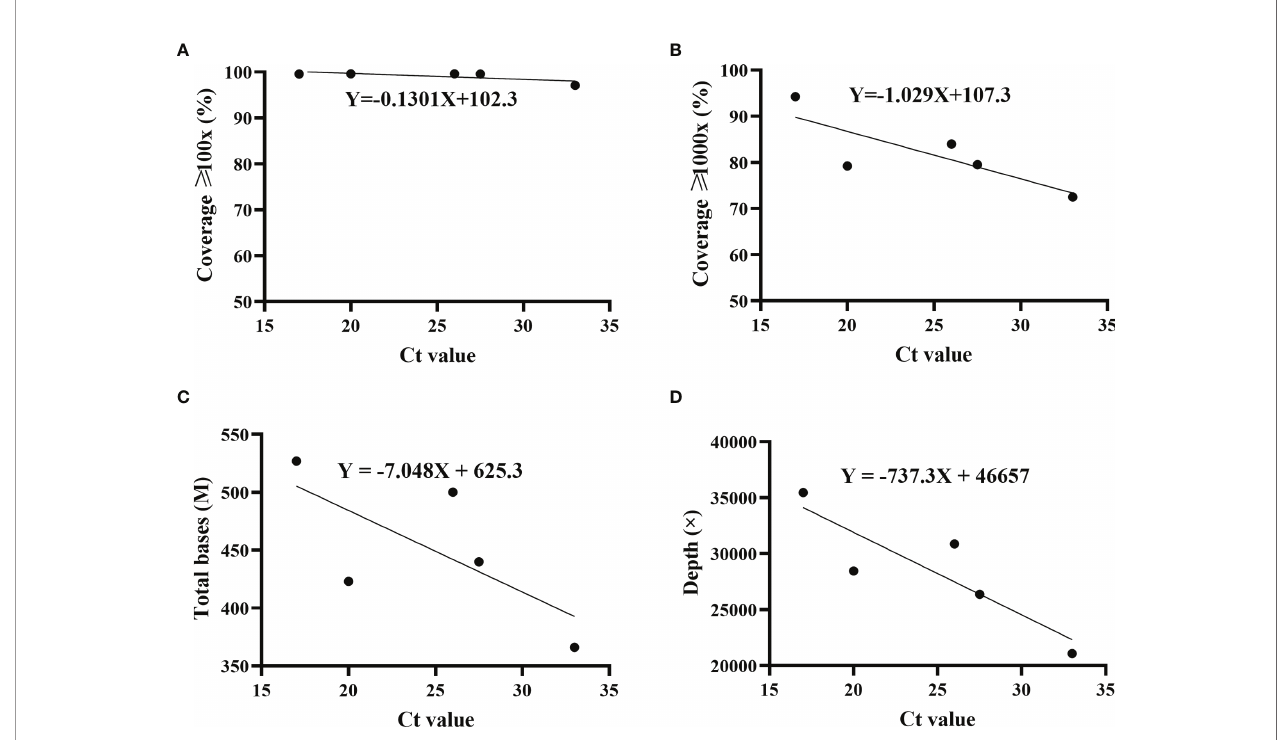
FIGURE 3 | Correlation of sequencing parameters and Ct value. The correlation was analyzed using simple linear regression. Ct values were determined by ORF1ab and N genes, and the average was displayed. For each set, including sequencing coverage (A, B) , ≥ total bases (C) and sequencing depth ≥ (D) with different Ct values, regression equation was calculated. Patient 1, R 2 = 0.5356; patient 2, R 2 = 0.6551; patient 3, R 2 = 0.4867; patient 4, R 2 = 0.7648.